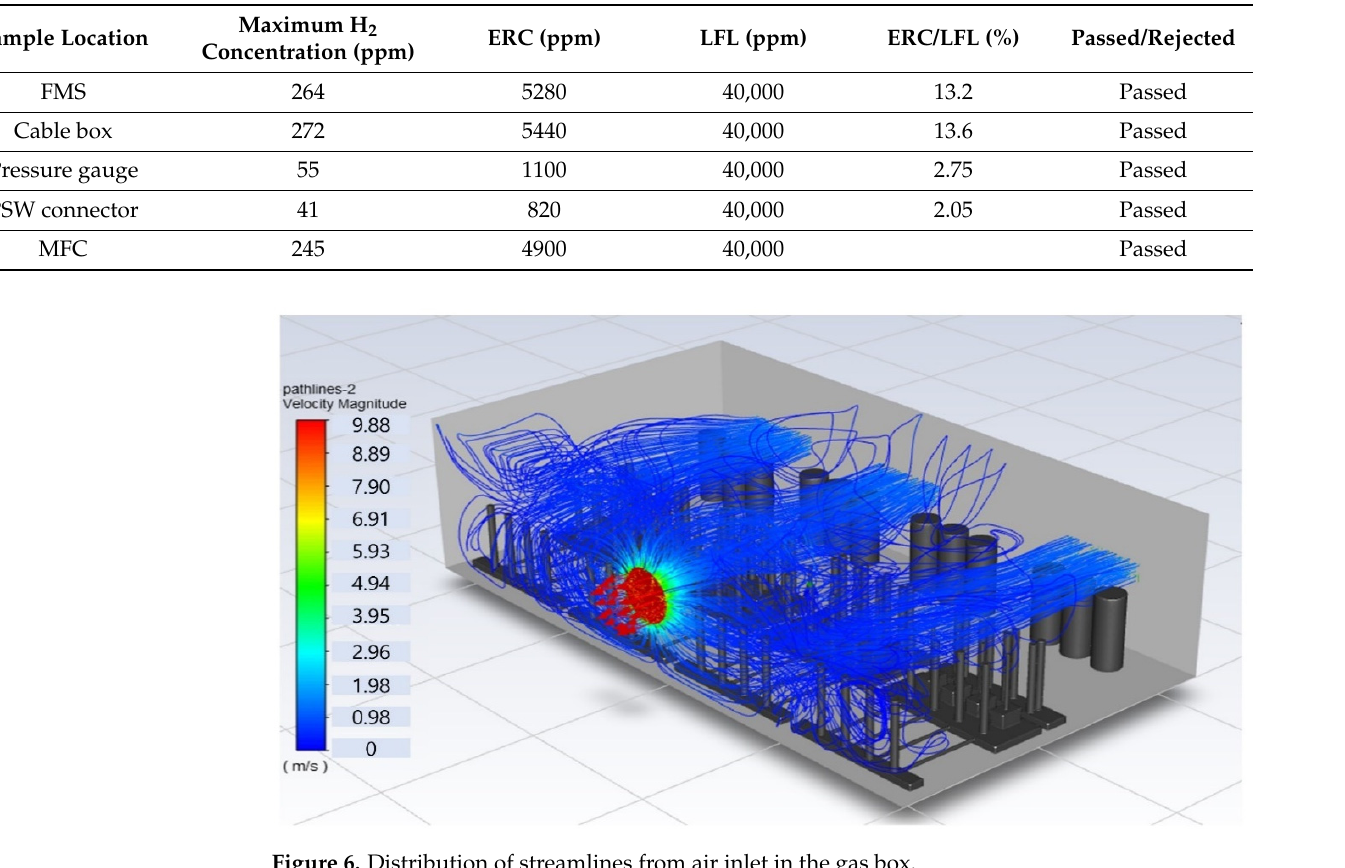
Table 6. CFD simulation result.